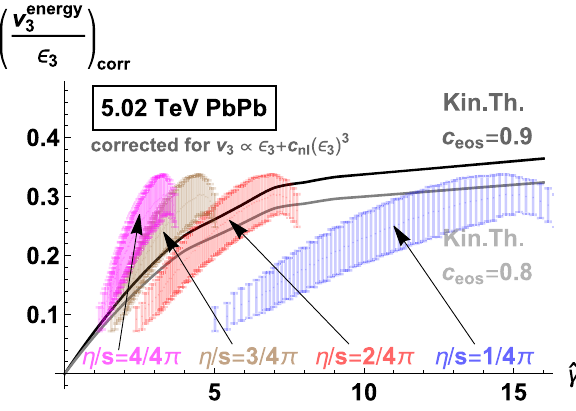
Fig. 11 Same as Fig. 10, but for the ratio v 3 /(cid:17) 3 as a function of ˆ γ . Since (cid:17) 3 is significantly smaller than (cid:17) 2 , correcting or not correcting with Eq. (39) for the non-linear (cid:17) 3 -dependence of v 3 makes a negligible effect